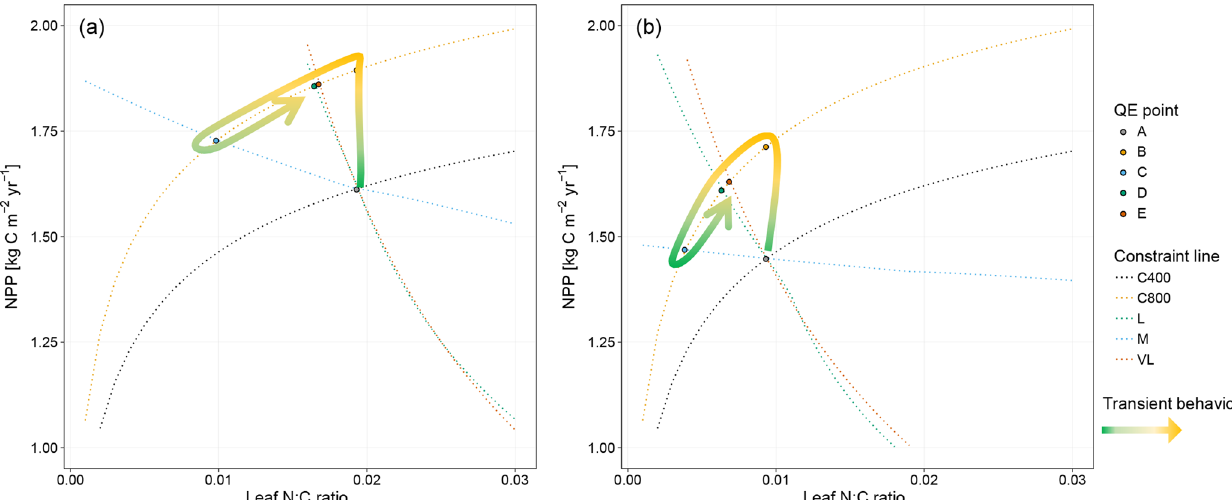
Figure 1. Graphic expression of the baseline quasi-equilibrium framework in understanding plant production response to elevated CO 2 based on photosynthetic (C400, C800 refer to CO 2 = 400 and 800ppm, respectively) and nitrogen cycling constraints in the medium (M), long (L), and very long (VL) terms under the assumption of a (a) variable wood N:C ratio and a (b) fixed wood N:C ratio. The photosynthetic constraint is an analytical expression of the Farquhar leaf photosynthesis model that relates leaf chemistry (i.e., N:C ratio) to production, simplifying leaf to canopy scaling. The nutrient recycling constraint is an analytical expression of the soil nutrient downregulation effect on production, assuming soil organic matter structures as in Fig. 2. The quasi-equilibrium points at various timescales (A, C, D, and E) were calculated by solving for the intersection of the photosynthetic and nutrient cycling constraints through the two-timing approximation. Initially the system is in equilibrium between photosynthetic N demand and soil N supply at CO 2 = 400ppm (A). The instantaneous response to a doubling of CO 2 is a sharp increase in production at a constant leaf N concentration (B). Under nutrient-limited conditions, the soil N supply cannot sustain this increase in production over time. A negative feedback moves the quasi-equilibrium point towards point C, where the M-term pools equilibrate with eCO 2 . The system gradually moves toward point D and E as the L and VL pools equilibrate. The downward slopes of the N recycling constraint curves with an increasing leaf N:C ratio are due to the increased proportional loss of mineralized N through leaching as the rate of N cycling increases with leaf N concentration.